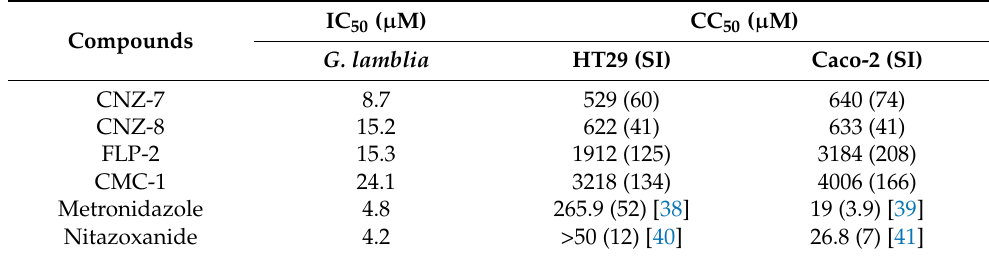
Table 3. In vitro giardicidal activity and selective cytotoxicity shown by selected compounds.